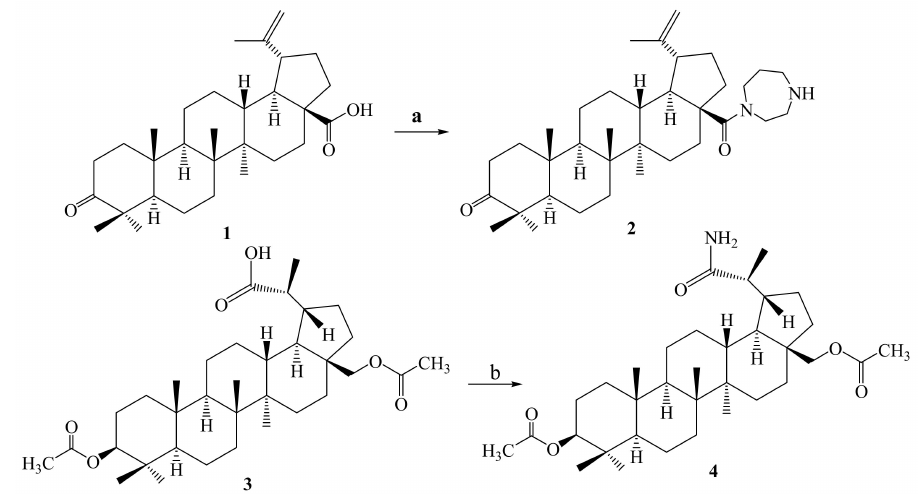
Scheme 1. Synthesis of compounds 2 and 4 . Reagents and conditions: (a) 1. (COCl) 2 , CH 2 Cl 2 , 25 ◦ C, 1 h; 2. homopiperazine, CHCl 3 , 22 ◦ C, 2 h; (b) 1. (COCl) 2 , CH 2 Cl 2 , 25 ◦ C, 1 h; 2. NH 3 , CHCl 3 , 22 ◦ C, 6 h. Compound 3 [25] .